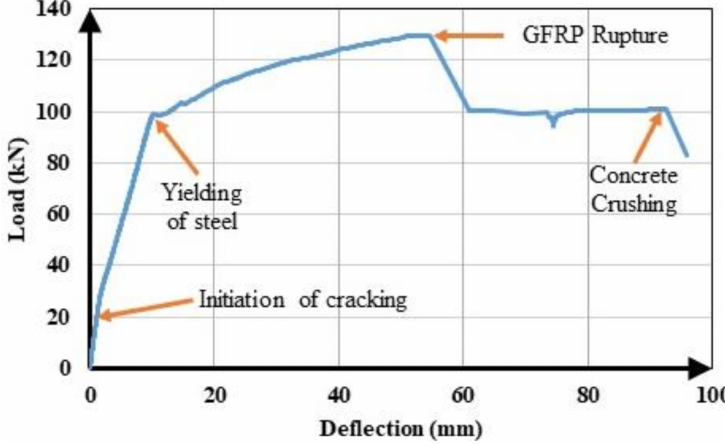
Figure 6. Complete load-deflection curve of